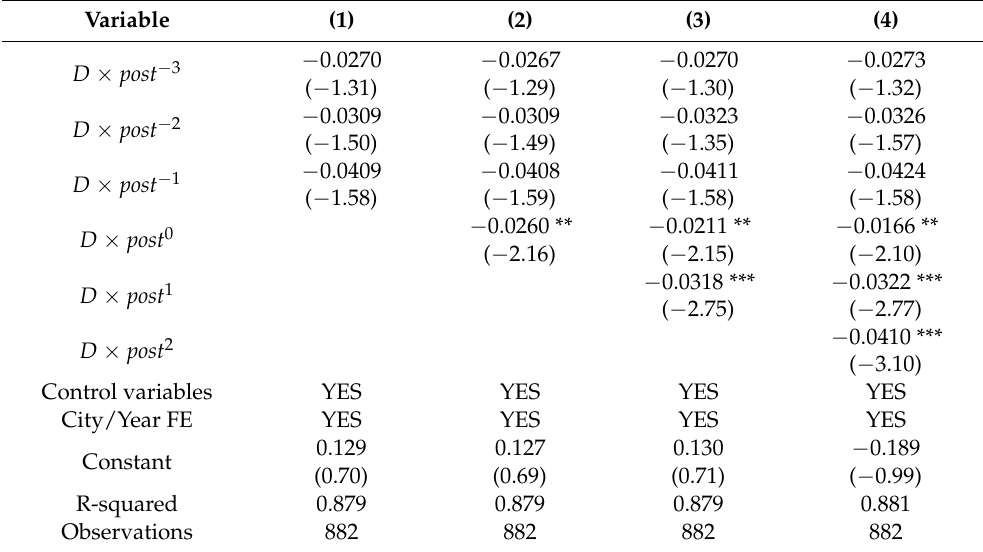
Table 4. Results of the parallel trend test.